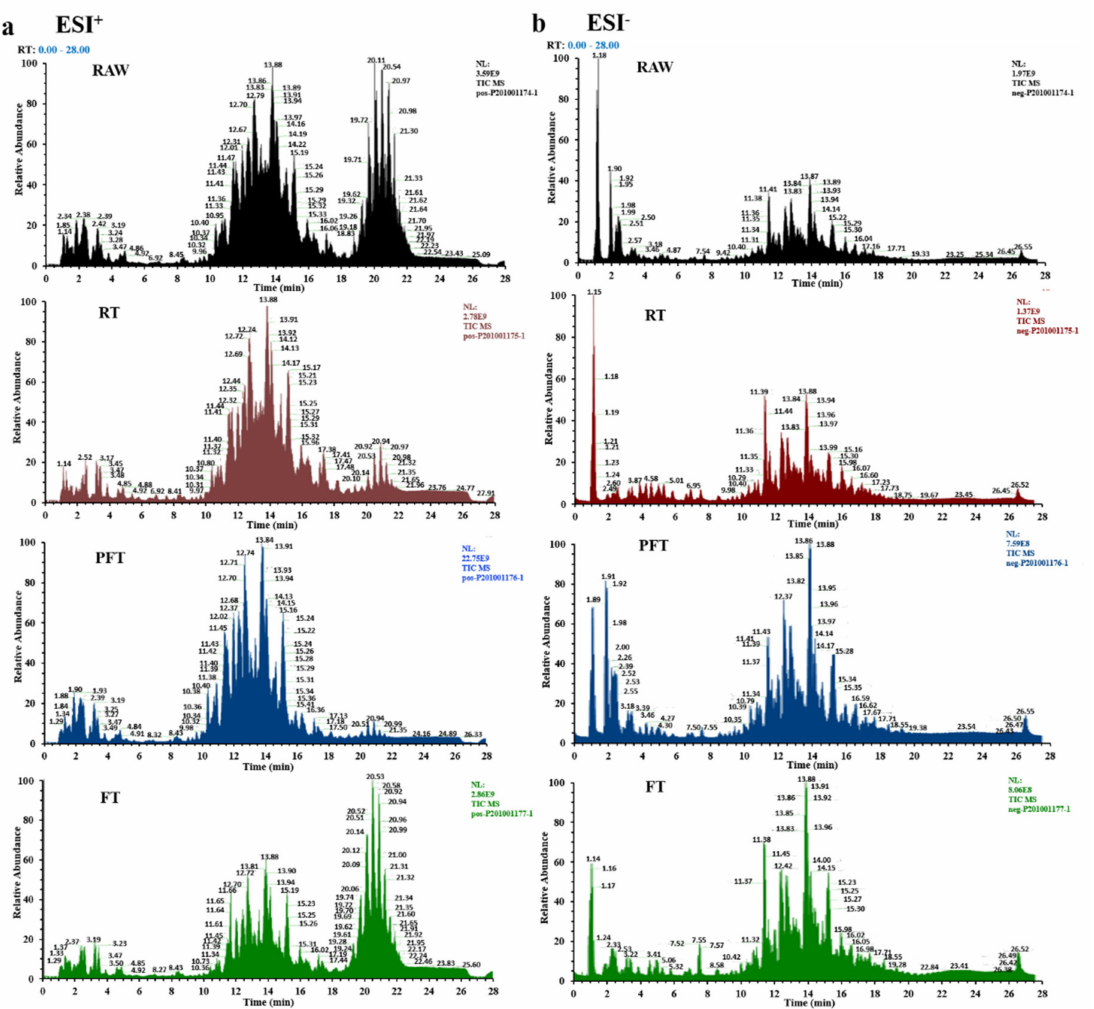
Figure 1. UPLC-Exactive Orbitrap/MS base peak intensity chromatograms of L. vannamei acquired in ESI + ( a ) and ESI − ( b ) modes. Note: ESI + : positive electrospray ionization; ESI − : negative electrospray ionization; RAW: fresh group; RT: refrigerated treatment (4 ◦ C); PFT: particle-freezing treatment ( − 2 ◦ C); FT: frozen treatment ( − 18 ◦